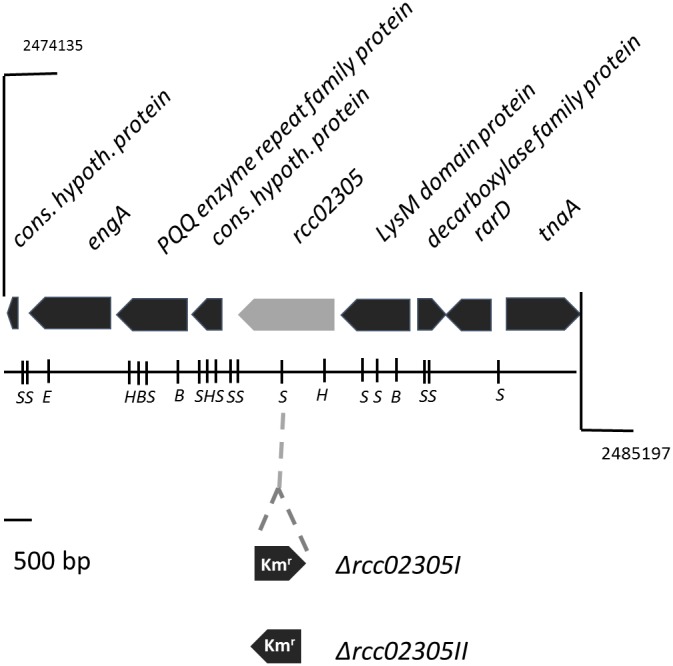
Gene region of rcc02305. The localizations of open reading frames are indicated by arrows carrying their respective gene designations. The gene rcc02305 is colored in light gray. The insertion of a kanamycin resistance cassette (Kmr) at the SmaI restriction site is indicated. The orientation of the interposon and the resulting strains Δrcc02305I and Δrcc02305II are shown below the gene region. B, BamHI; E, EcoRI; H, HindIII; S, SmaI.